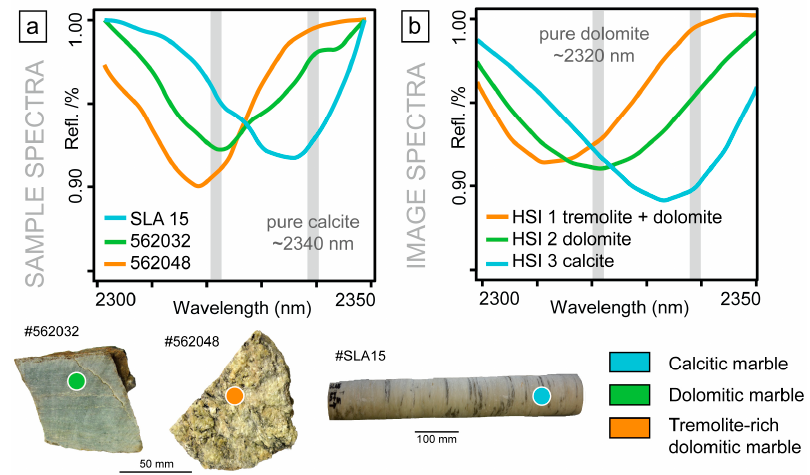
Figure 8. Spectral validation of the Minimum-Wavelength-Position-based mapping of the carbonate composition at Nunngarut test site. ( a ) Lab point spectra of three carbonate samples of the Maarmorilik formation, representing typical calcitic, dolomitic, and tremolite-rich dolomitic end members; ( b ) HSI spectral plot of the sampling positions marked in Figure 9, representing calcite-, dolomite-, and tremolite-rich dolomitic end members of the scene. A continuum removal was applied on all spectra. Elemental and mineralogical composition is further validated by portable XRF (pXRF) and thin section analysis, respectively (see Rosa et al. [19]).